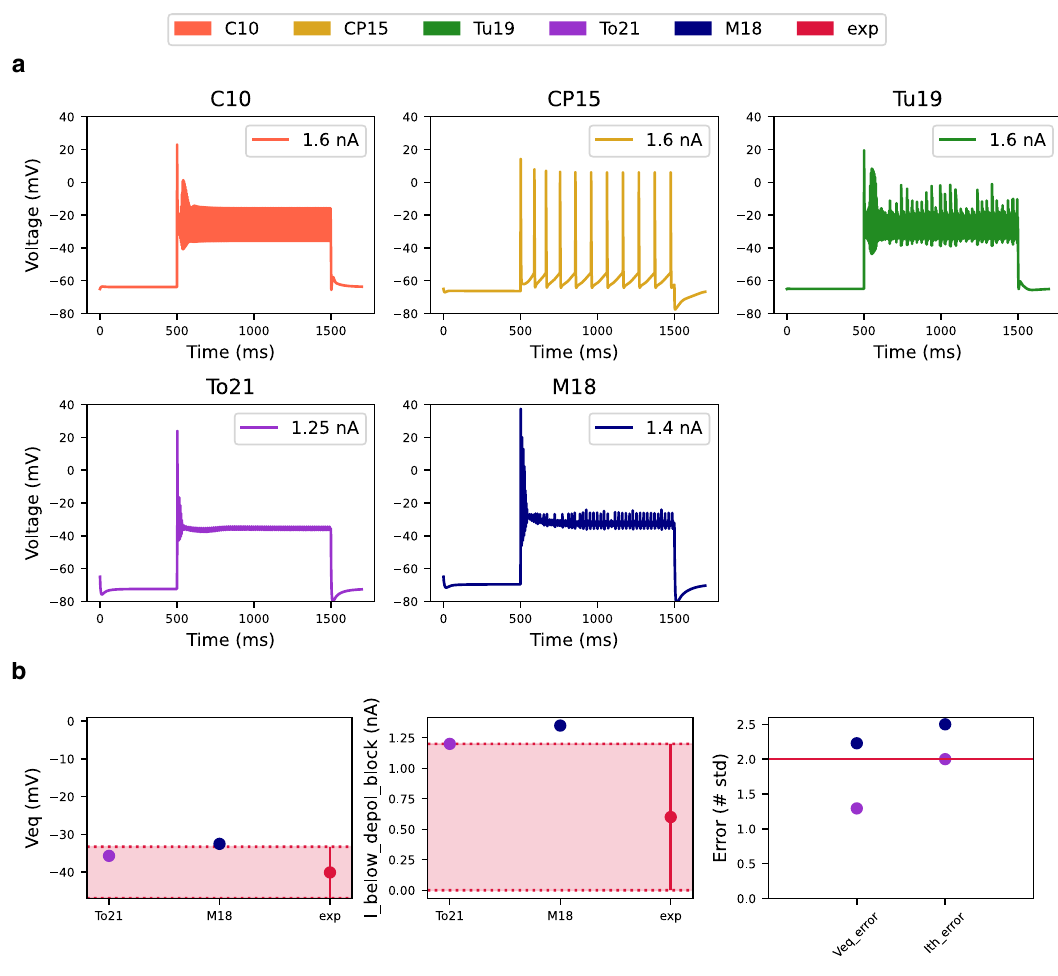
Figure 2. The Depolarization Block Test expressed the ability of models to enter depolarization block under sustained input current. ( a ) Somatic voltage response of models to the current at which the models entered depolarization block. If the model did not enter depolarization block, the somatic voltage response is the response to the maximum current intensity. ( b ) The values of the equilibrium voltage during depolarization block, the current intensity before the model enters depolarization block, and associated errors in these features expressed by the number of standard deviations for models that have entered depolarization block. Experimental values with the double standard deviations were obtained from the paper of Bianchi et al. 12 . The red horizontal line represents sd = 2 and determines the maximum error